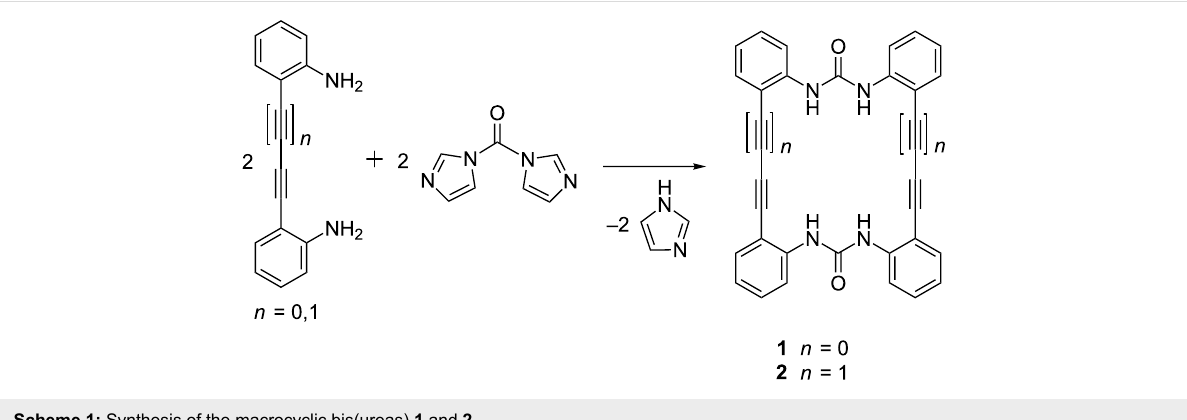
Scheme 1: Synthesis of the macrocyclic bis(ureas) 1 and 2